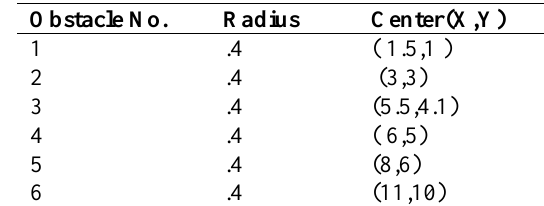
Fig. 9. Best shortest path for case 2.